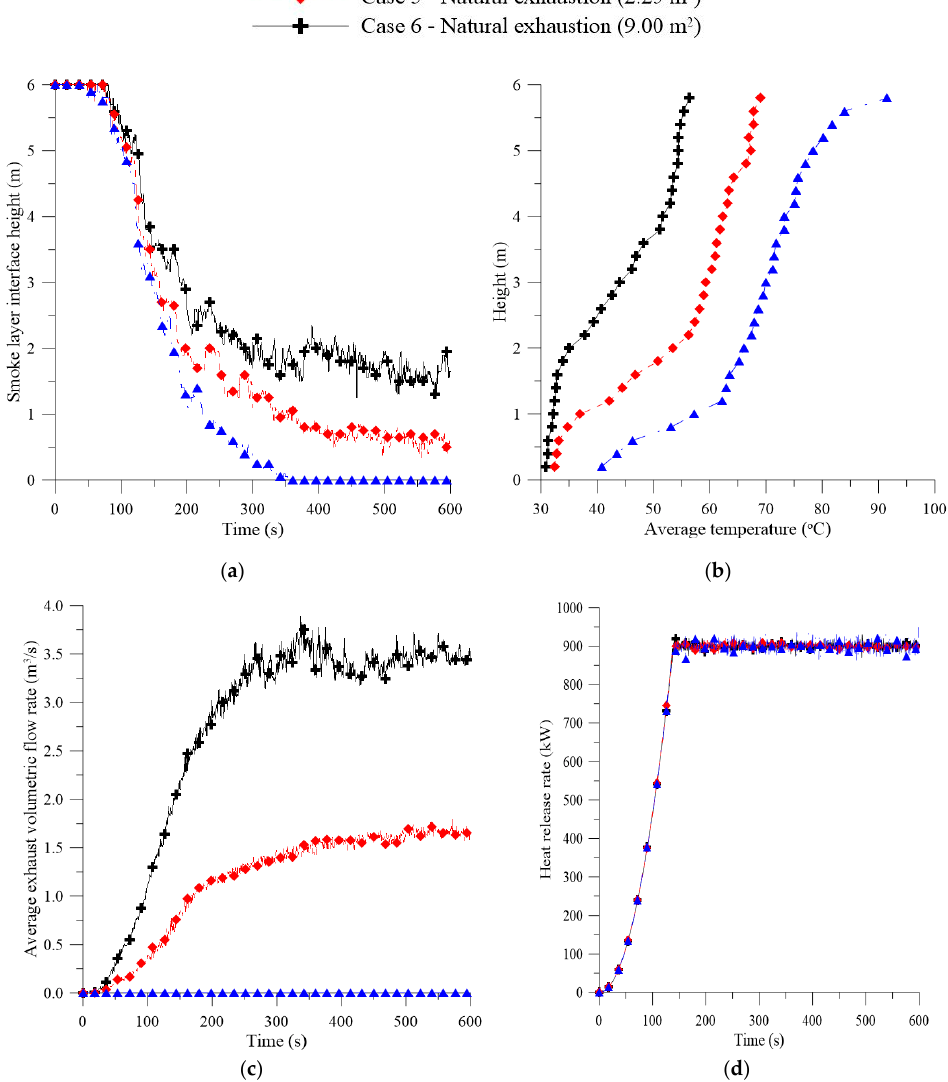
Figure 7. Influence of the natural exhaust area in the ( a ) smoke layer vertical displacement; ( b ) average temperature profile at t = 600 s; ( c ) average exhaust volumetric flow rate and ( d ) HRR (compartment with open windows and HRR = 900 kW).